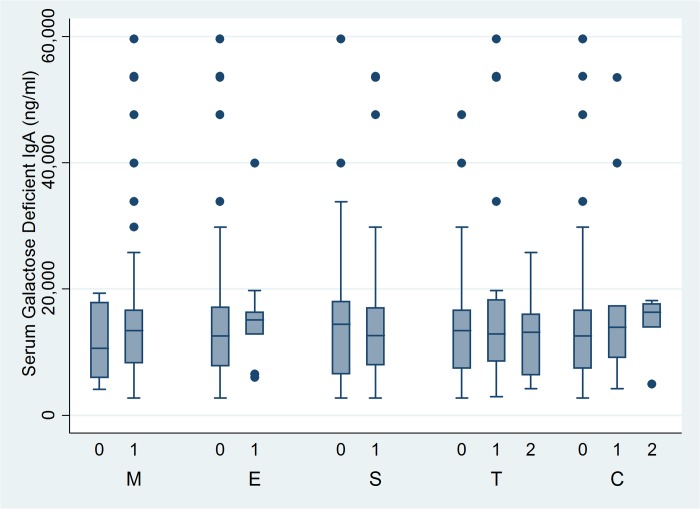
Serum Gd-IgA1 levels according to histologic severity of disease as per Oxford MEST-C criteria.